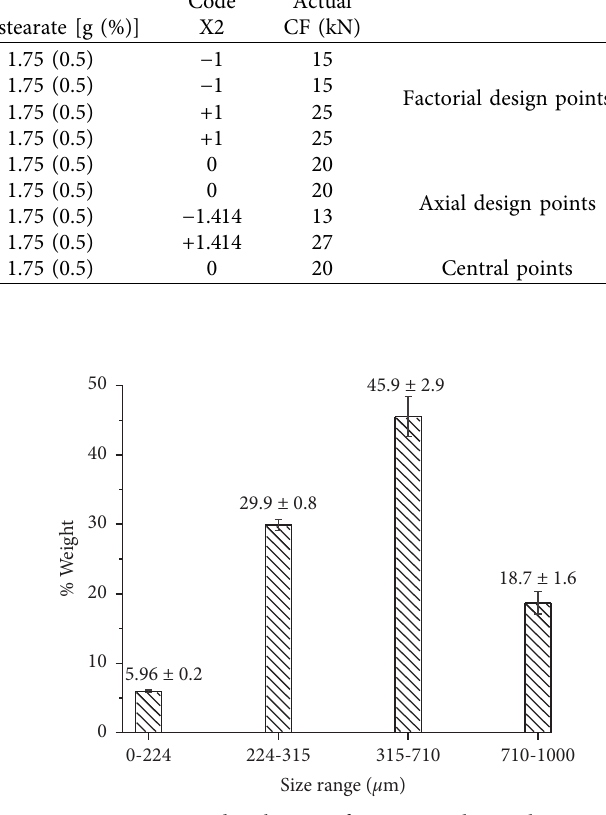
Figure 1: Size distribution of paracetamol